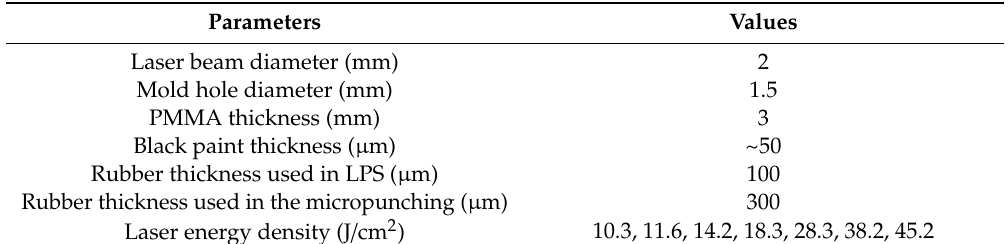
Table 1. Detailed experimental parameters.